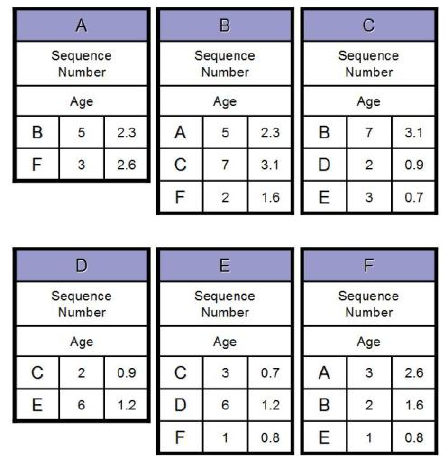
Figure A4. Link state packets for all nodes in simple